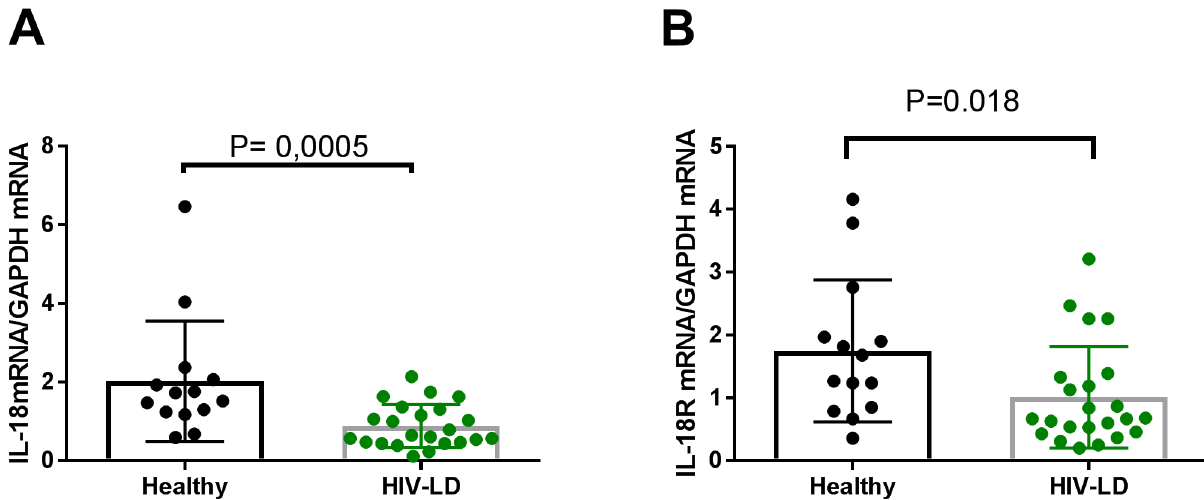
Fig 1. Patients with HIV-lipodystrophy have reduced levels of IL-18 mRNA and IL-18 receptor mRNA in skeletal muscle. (A) mRNA expression of IL-18 in skeletal muscle. In the healthy control group 2 subjects had very high levels of IL-18 mRNA levels. Even if those two subjects were deleted the difference between healthy controls and patients with HIV-Lipodystrophy were still high significant p = 0.003). (B) mRNA expression of IL-18 receptor in skeletal muscle. The levels of IL-18 mRNA and IL-18 receptor mRNA were calculated with GAPDH as a housekeeping gene. In the dot plots data for each subjects are given and the line represent means and SD. (cid:3) P < 0.05 and (cid:3)(cid:3)(cid:3) P < 0.001 for healthy vs HIV-lipodystrophy